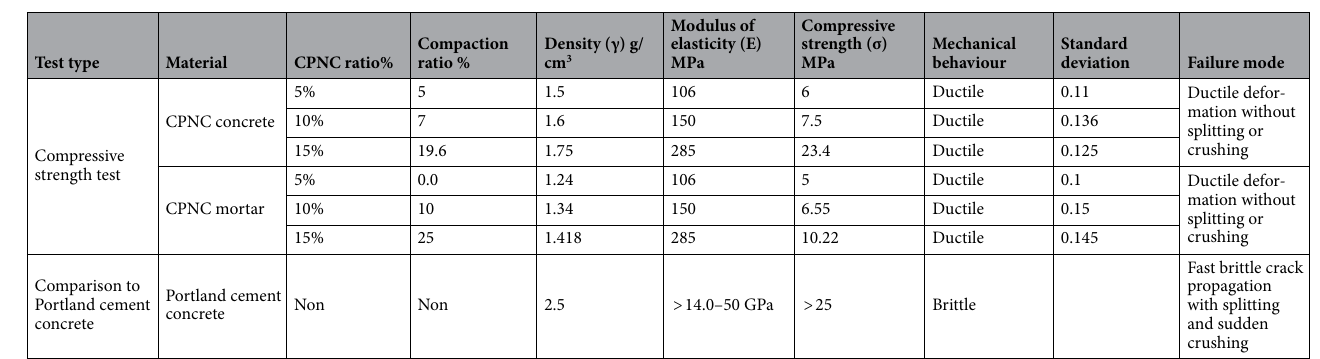
Table 2. Compressive strength properties, mechanical behaviours, and failure modes of CPNC concrete and CPNC mortar relative to those of Portland cement concrete; the results show big differences as CPNC concrete behaviour is lightweight and ductile without sudden failure or crushing, unlike Portland cement